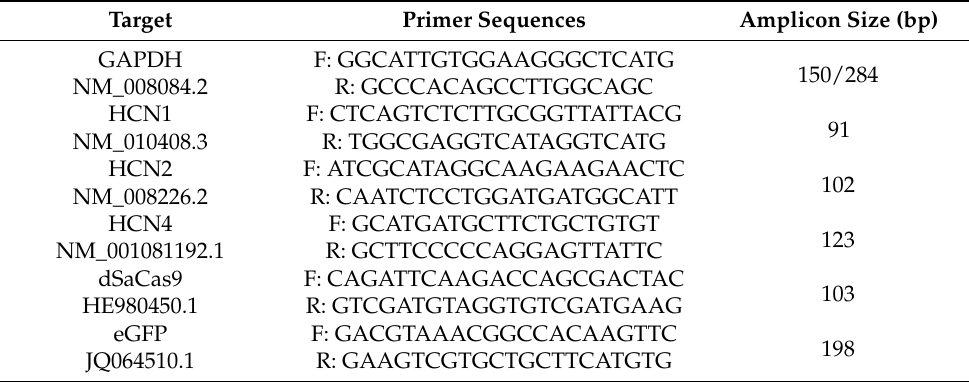
Table 3. Primer Pairs Used for RT-qPCR analysis. Primer sequences (F, forward; R, reverse) and Amplicon Sizes are Based on Species-Specific cDNA Sequences. Amplicon Sizes of gapdh fragments are Indicated for Amplification on cDNA (150 bp) or on Genomic DNA (284 bp), thus allowing to monitor genomic